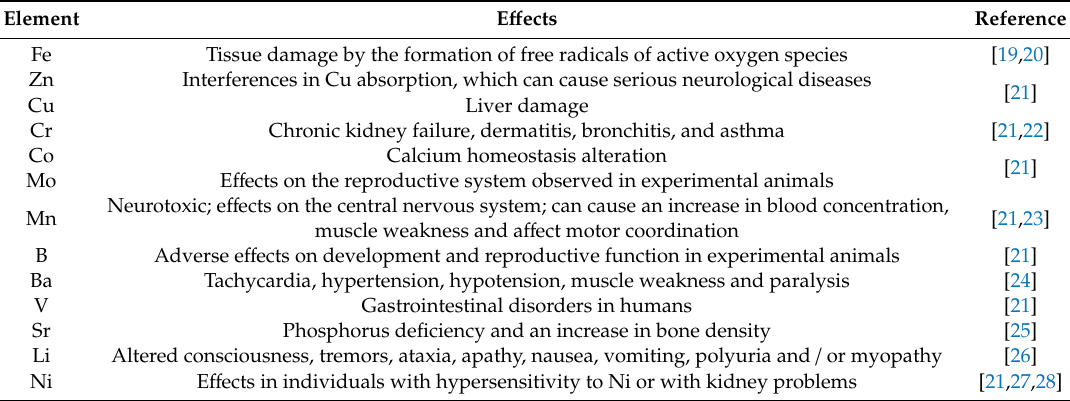
Table 1 summarized the principal adverse e ff ects caused by high intakes of these elements. Table 1. Possible adverse e ff ects caused by high intakes of trace